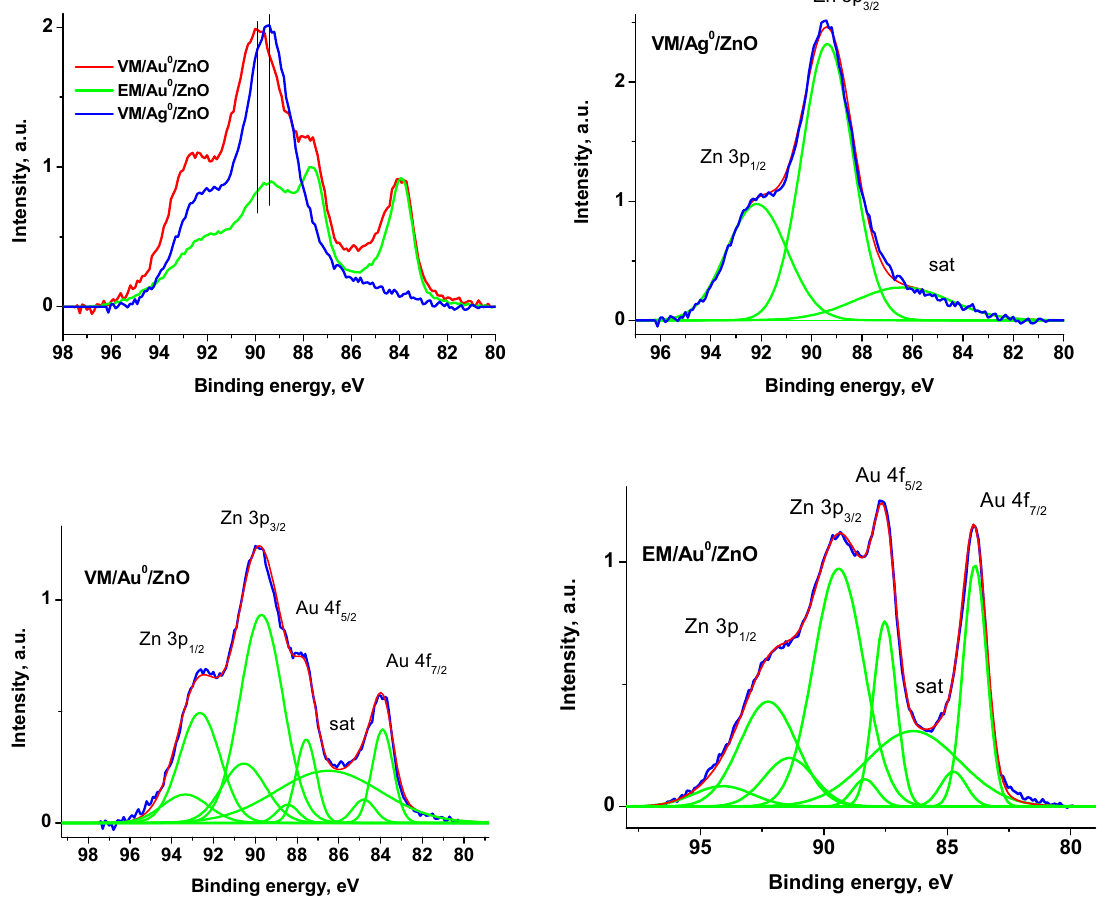
Figure 6. The Au 4f and Zn 3p high-resolution spectra of the VM/Au 0 /ZnO, EM/Au 0 /ZnO, and VM/Ag 0 /ZnO samples.